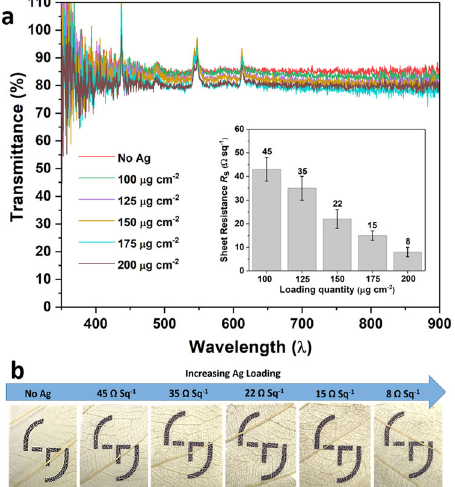
Fig. 2 Transmittance studies. a Optical transmittances of bioin- spired heater electrode at different sheet resistances. Inset shows the relationship of sheet resistance at different Ag nanowire loading. Three independent measurements were done, and the error bars show the standard deviation. b Camera images displaying the transparency of the bioinspired heater electrode at different sheet